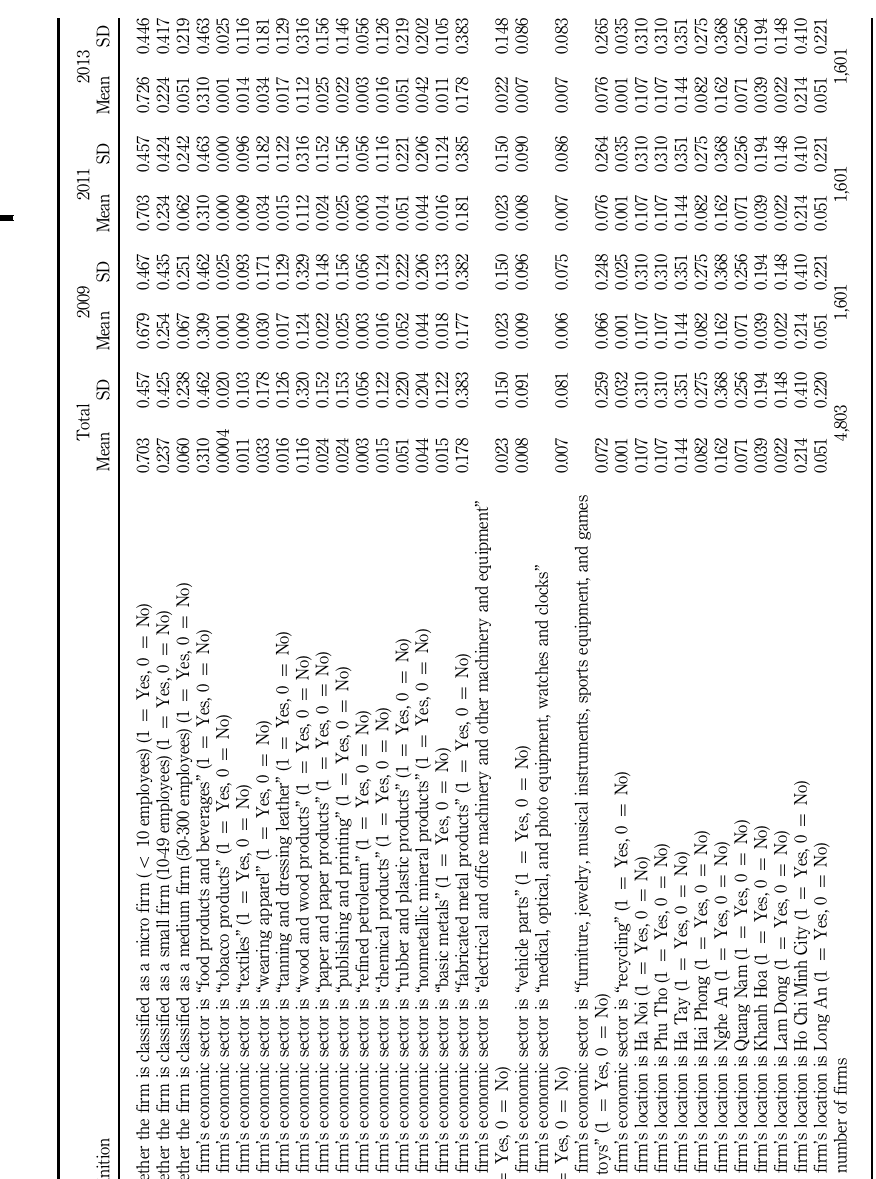
Table AII. Additional summary statistics of the sample (firm size, economic sectors and